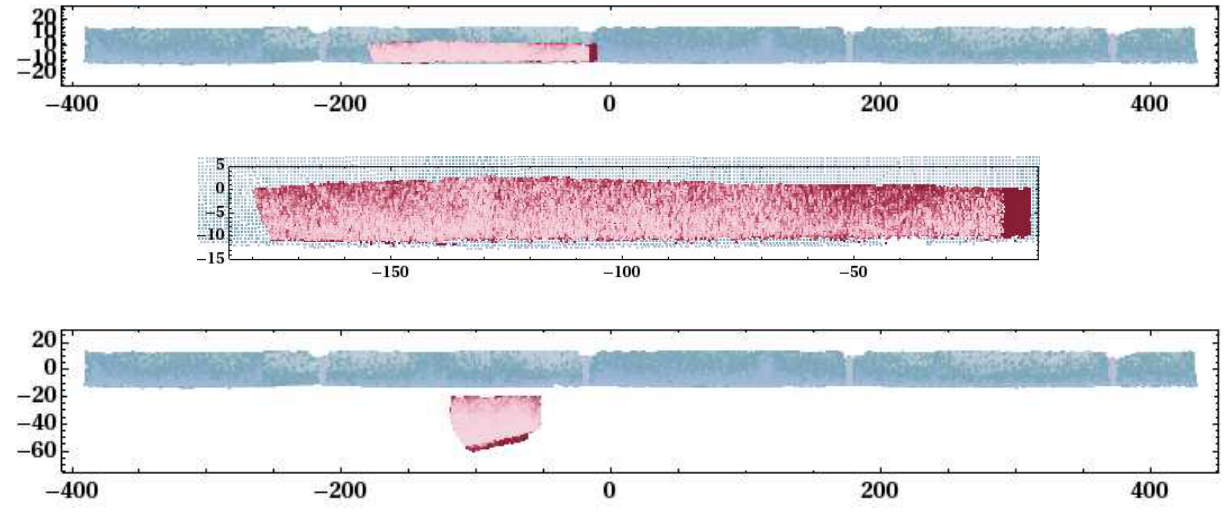
Figure 2: Top: Two intersecting segments, with blue and red points resp. , in a common segment plane; Middle: Same, but zoomed in on the red points; Right: Two non-intersecting segments in the same segment plane. Axes are labeled in centimeter. 3.4 Possible large